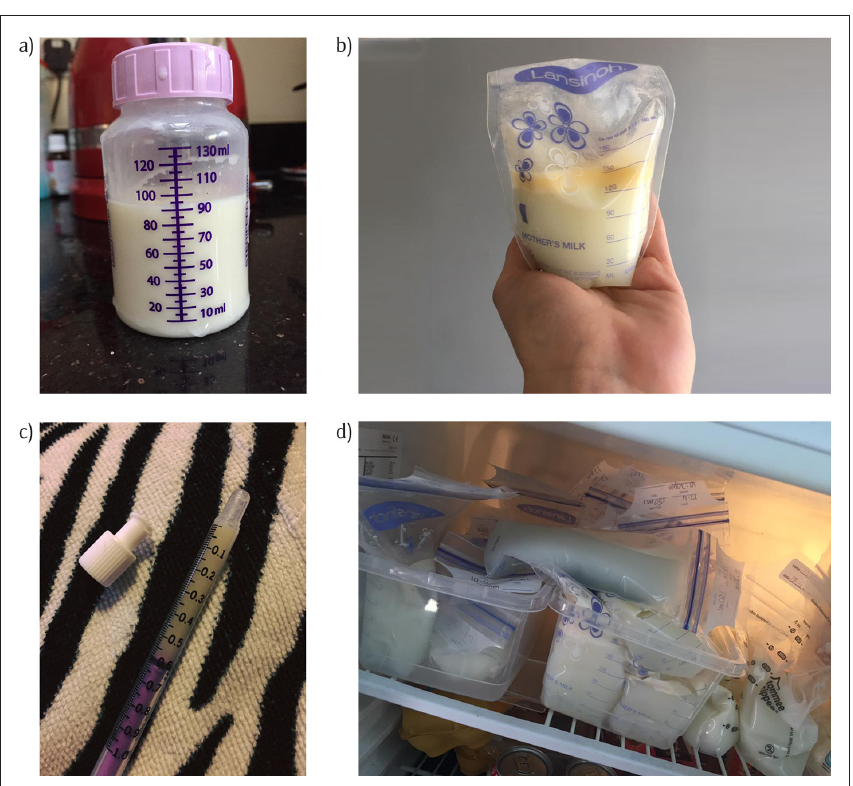
text (left to right): Success in relactation; strange colour and texture; harvesting colostrum for a child likely to be in NICU; stash storage safety (Source: Facebook breastfeeding support group